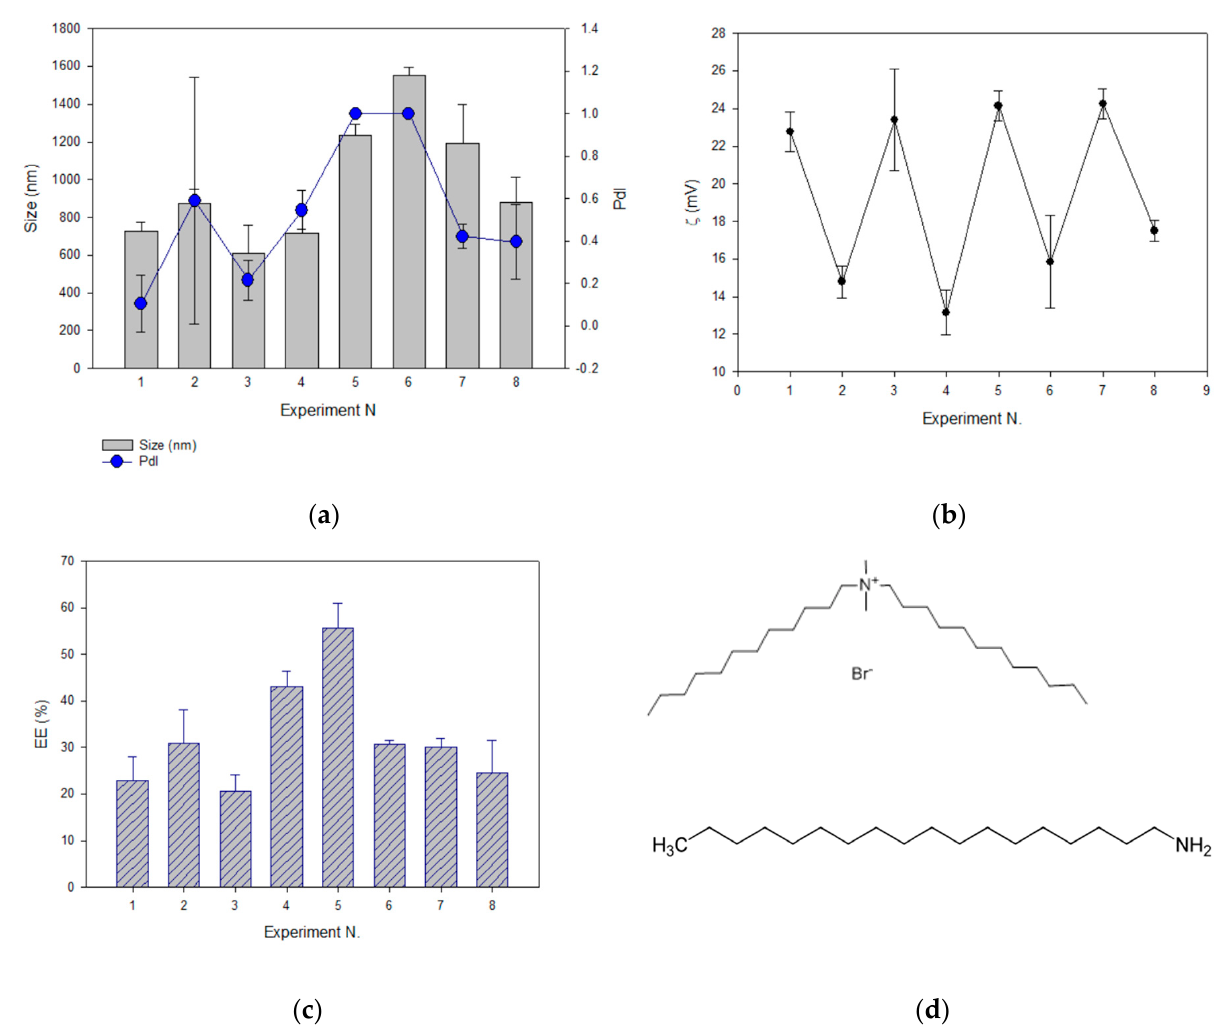
Figure 3. The effect of formulation parameters on ( a ) vesicle size (d H , nm) and PdI; ( b ) zeta potential (ZP, mV); ( c ) encapsulation efficiency of Acz (EE). Experiments were conducted in duplicate. ( d ) Chemical structures of DDAB ( top ) and SA ( bottom ). Table 4. ANOVA analysis for the responses evaluated. A p -value < 0.001 was considered statistically